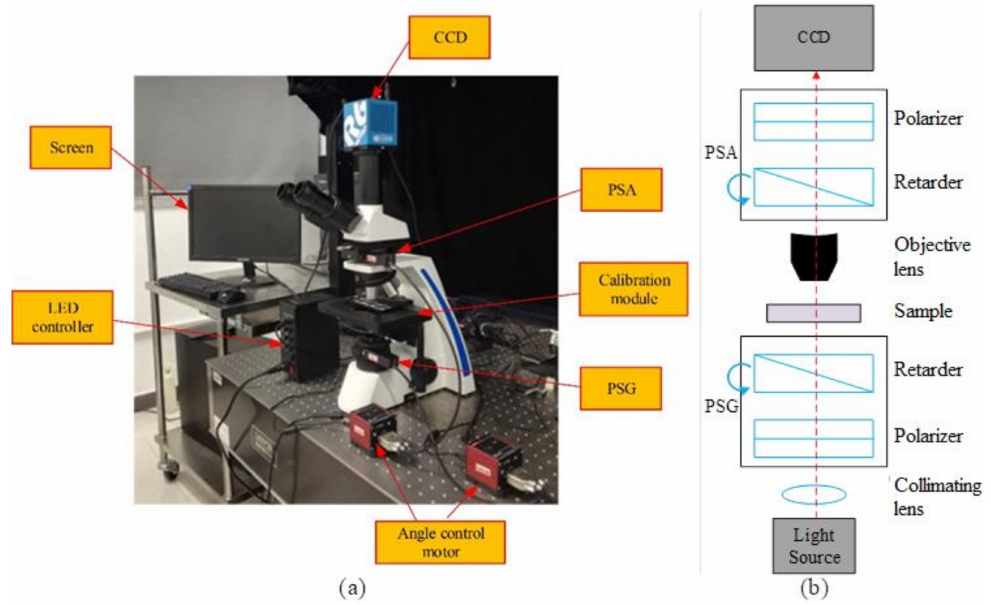
Figure 1. ( a ) Photograph and ( b ) schematic of the Mueller matrix microscope. Here, CCD: charge-coupled device, LED: light-emitting diode, PSA: polarization state analyzer, and PSG: polarization state